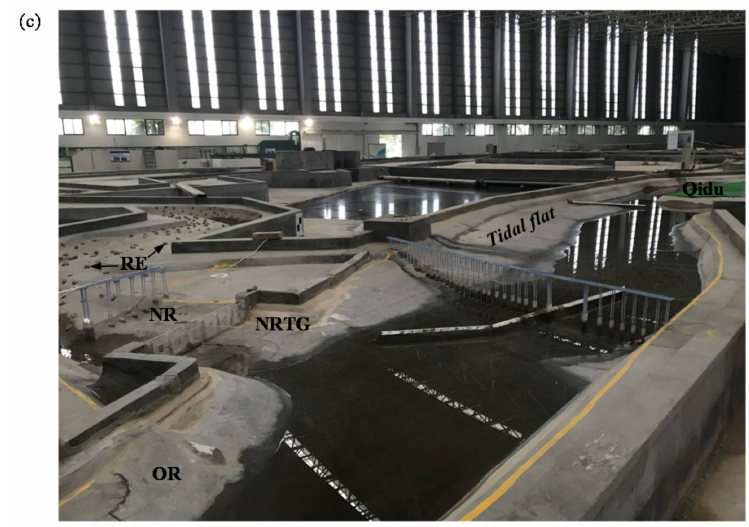
Figure 2. Model layouts: ( a ) a sketch map of the experimental model, ( b ) the scheme of the tidal maker and data acquisition system, and ( c ) the model site. RE: Roughness